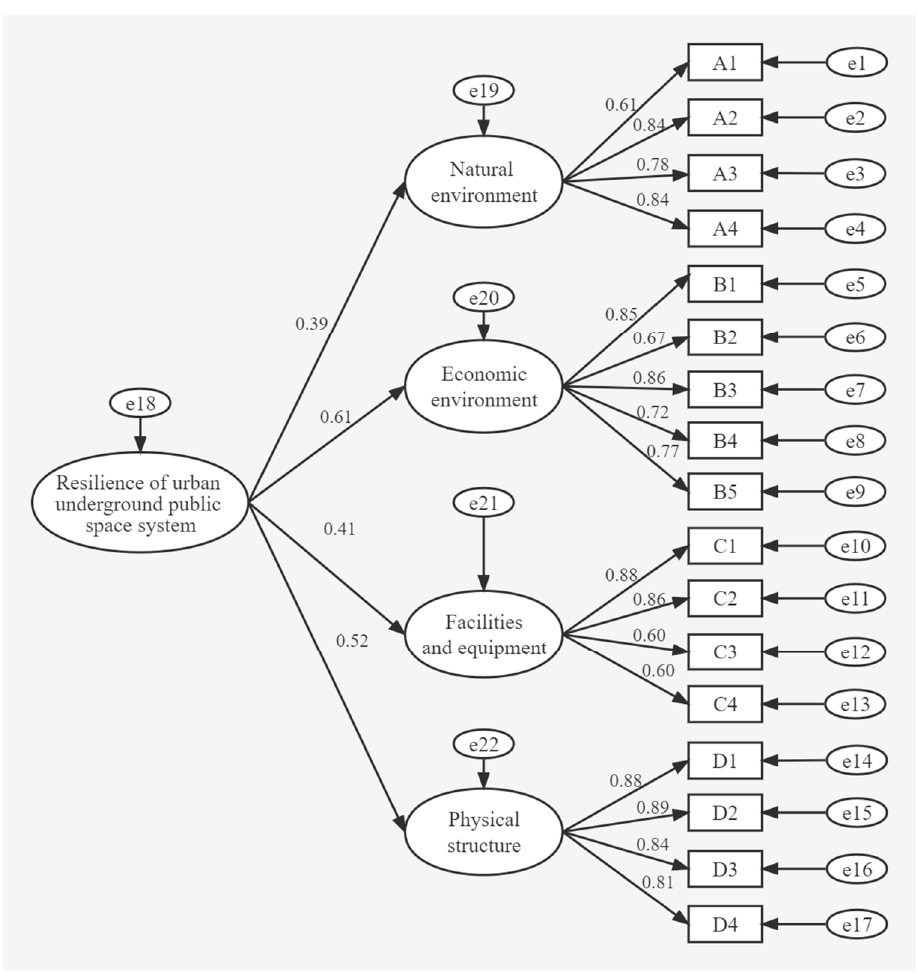
Figure 3. Path coefficients of the second-order structural equations model of underground public space (UPS). Table 11. Criteria values and results of the model fitting